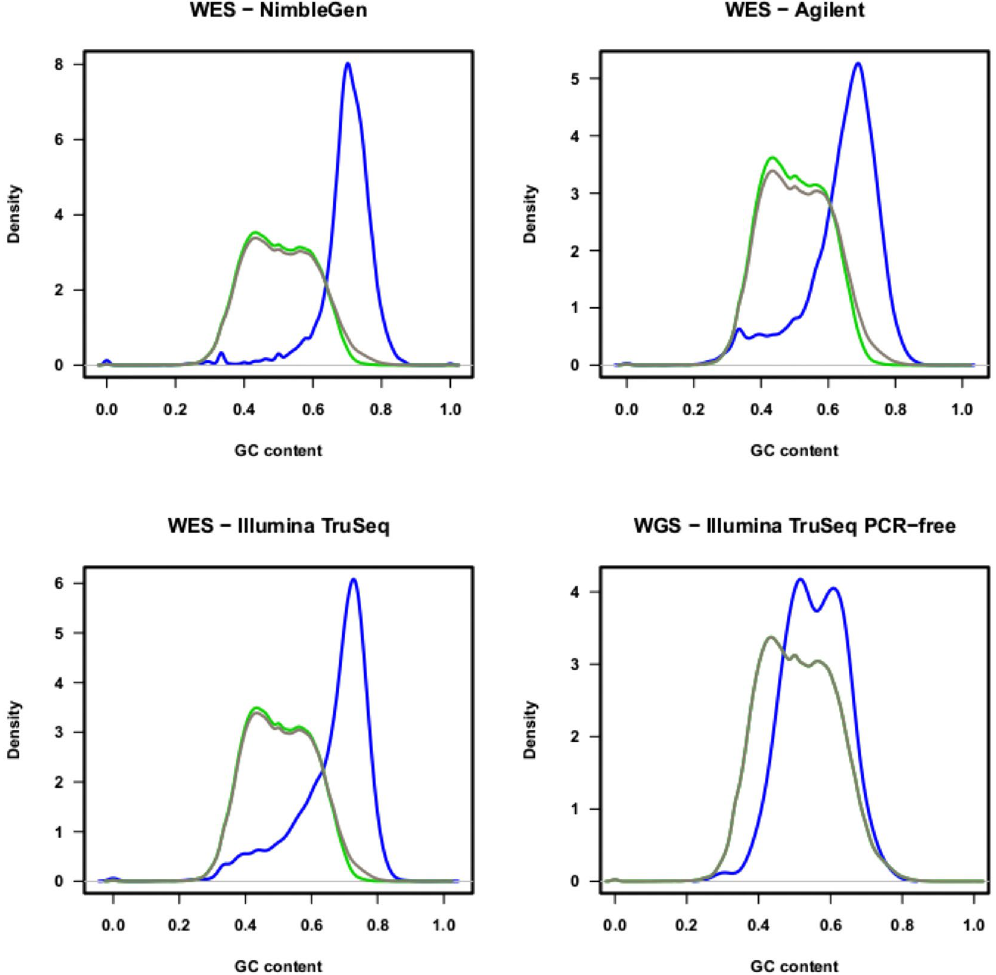
Figure 6. The probability density curves showing GC content in sets of genes with different coverage. The distribution of GC content of all genes (black), high coverage genes with CCS score < 0.2 (green), low coverage genes with CCS score > 0.2 (blue) are